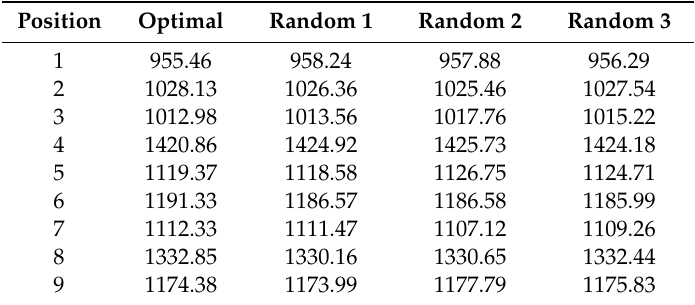
Table 6. Temperature values (K) for test reconstruction result.